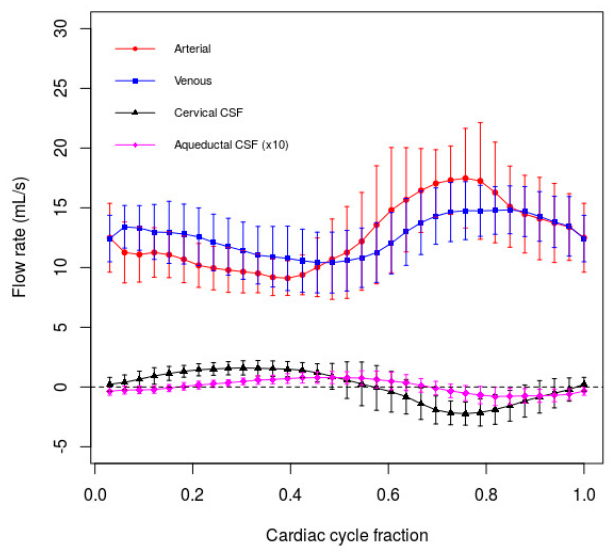
Figure 3. Ensemble mean arterial, venous, cervical CSF and aqueductal CSF signals for all subjects aggregated together. Error bars represent one standard deviation. (NB. The venous signal has been inverted for comparison purposes.). Table 2. Mean, minimum and maximum flow rates (with the computed pulsatility indices) for the cervical arterial, venous and CSF flows, together with aqueductal CSF flow, aggregated for all subjects.